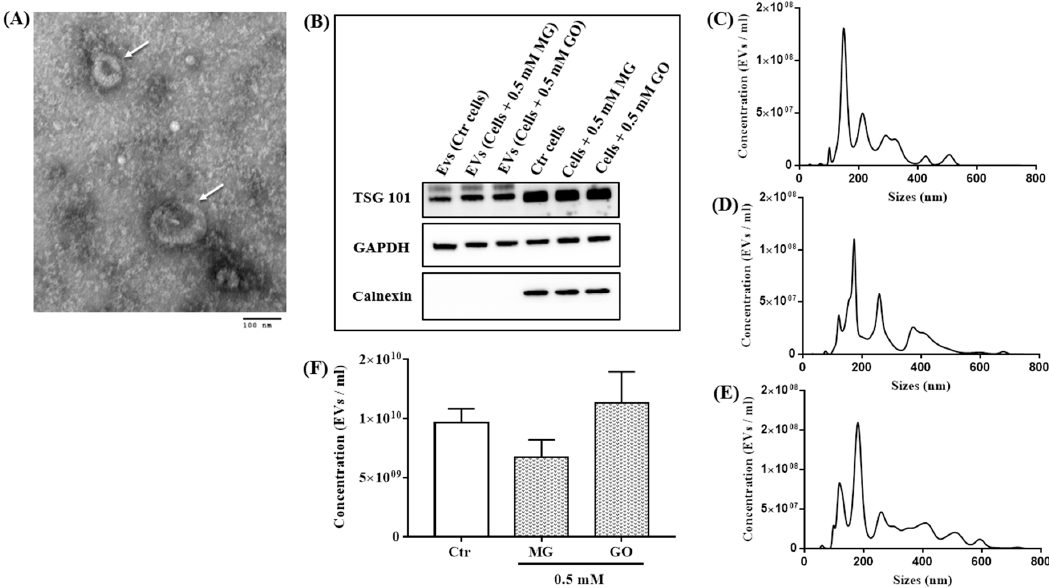
Figure 4. Characterization of nEVs isolated from controls and treated cells. The TEM image revealed the spherical morphology of the isolated particles (White arrow), bar = 100 nm ( A ). Expressions of EVs marker (TSG101), the presence of GAPDH and the negative control (Calnexin) analyzed by Western blot on protein lysates from EVs and SK-N-SH cells ( B ). Concentrations and size of isolated EVs from control cells ( C ), MG-treated cells ( D ) and GO-treated cells ( E ) were analyzed by NTA using Nanosight NS300 system. The concentrations of isolated EVs from control and treated cells with (MG and GO) were not di ff erent ( F ). Values are mean ± S.E.M (from three separate experiments) and data groups were compared with one-way ANOVA followed by the Dunnett’s post hoc test. Int. J. Mol. Sci. 2019 , 20 , x FOR PEER REVIEW